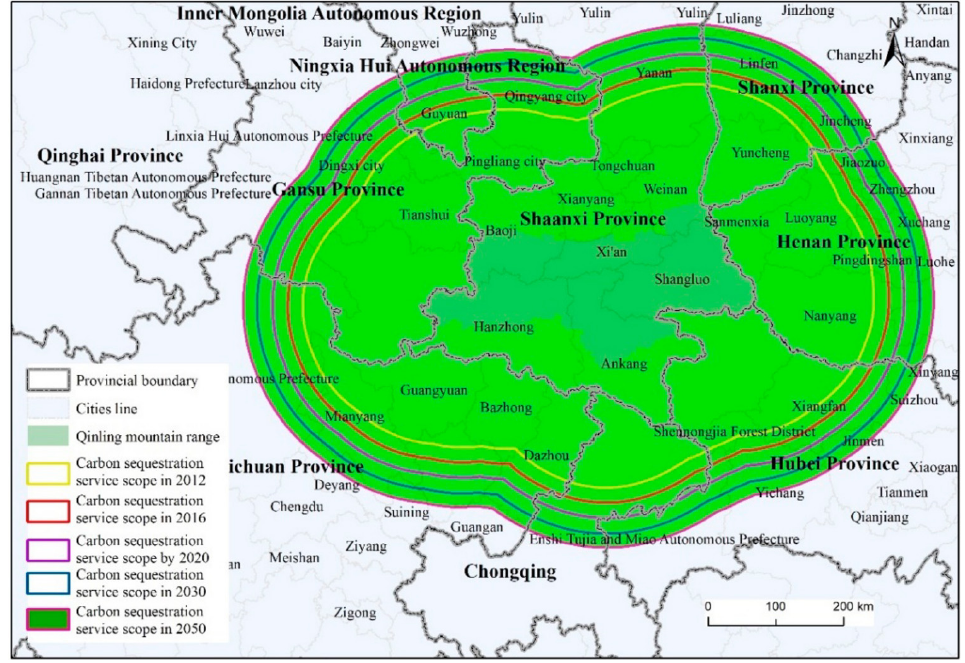
Figure 6. Diffusion range of carbon neutralization space services in the Qinling